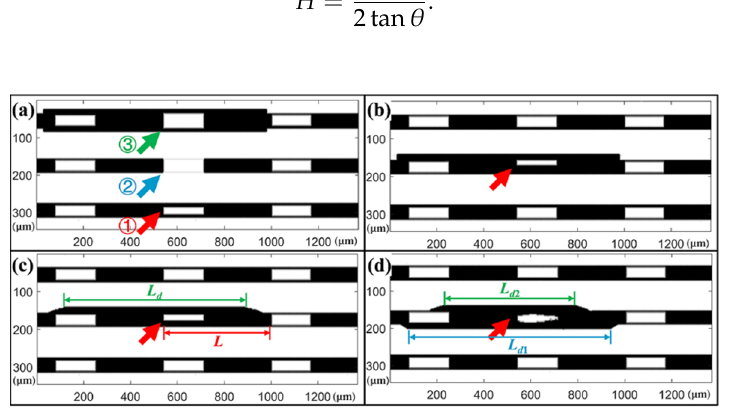
Figure 5. The simulated results of light reflected by structures with different shapes. ( a ) Trapezoidal structure with different base angles: ① 88°, ② 90°, and ③ 92°; ( b ) tilted structure; ( c ) C-shape distorted structure; ( d ) S-shape distorted structure.